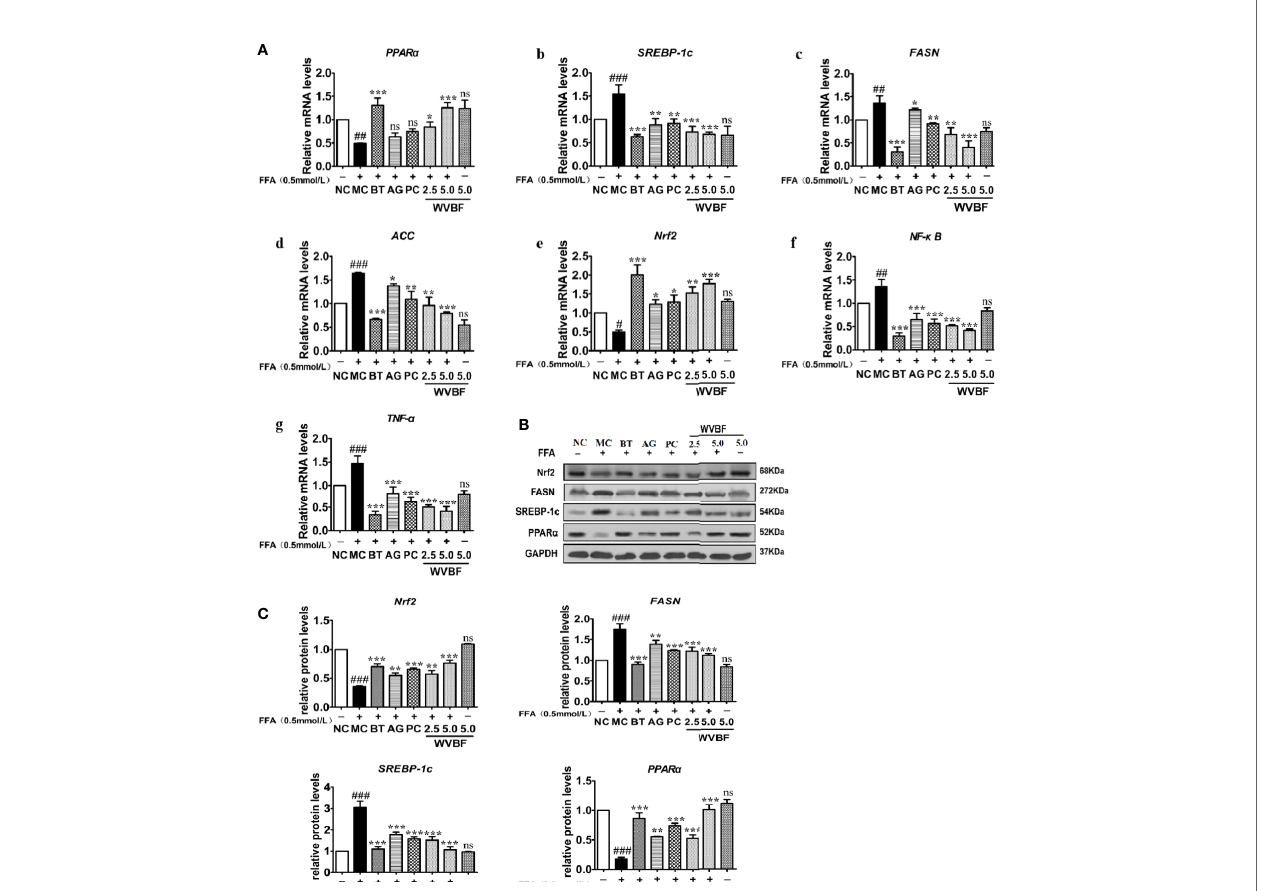
FIGURE 8 | Effect of water extract of Veratrilla baillonii (WVBF) on non-alcoholic fatty liver disease (NAFLD) lipid, oxidative stress, and in fl ammation of free fatty acids (FFA)-induced cell. (A) Effect of WVBF on the expression of PPAR a (a), SREBP-1c (b), FASN (c), ACC (d), Nrf2 (e), NF- ĸ B (f), and TNF- a (g) messenger RNA (mRNA). (B) Protein expression of PPAR a , SREBP-1c, fatty acid synthase (FAS), acetyl-CoA carboxylase (ACC), and Nrf2 in FFA-induced LO2 cell was detected by western blot. (C) Effect of WVBF on the expression of Nrf2, ACC, FASN, SREBP-1c, and PPAR a protein. n =3 ( n , the number of experiment), ( ## P < 0.01, ### P < 0.001, vs .